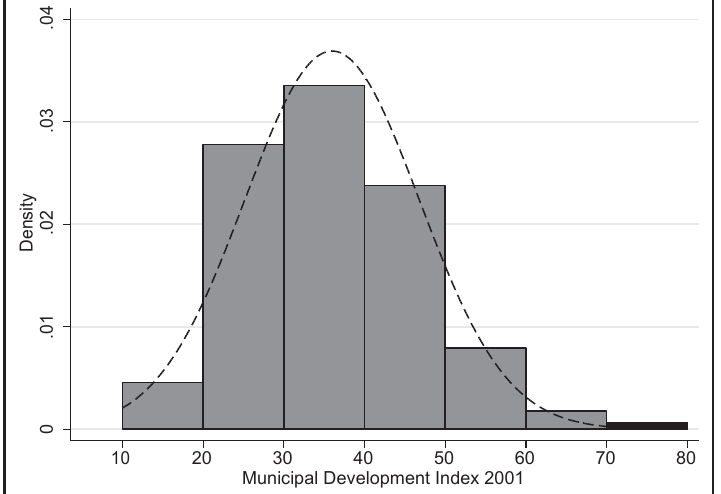
Municipal development index in the empirical sample. Notes: The figure plots the 2001 MDI values for our sample of cities. The normal curve is